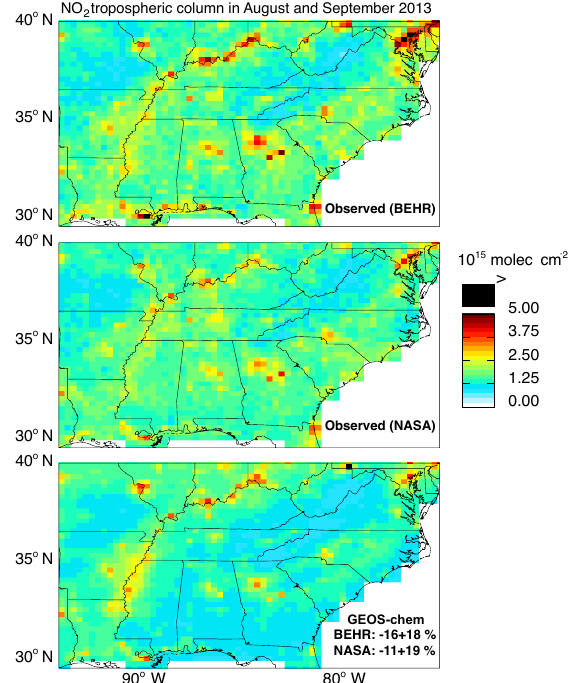
Figure 5. NO 2 tropospheric columns over the Southeast US in August–September 2013. GEOS-Chem (sampled at the 13:30 local time overpass of OMI) is compared to OMI satellite observations using the BEHR and NASA retrievals. Values are plotted on the 0.25 ◦ × 0.3125 ◦ GEOS-Chem grid. The GEOS-Chem mean bias over the figure domain and associated spatial standard deviation are inset in the bottom panel.